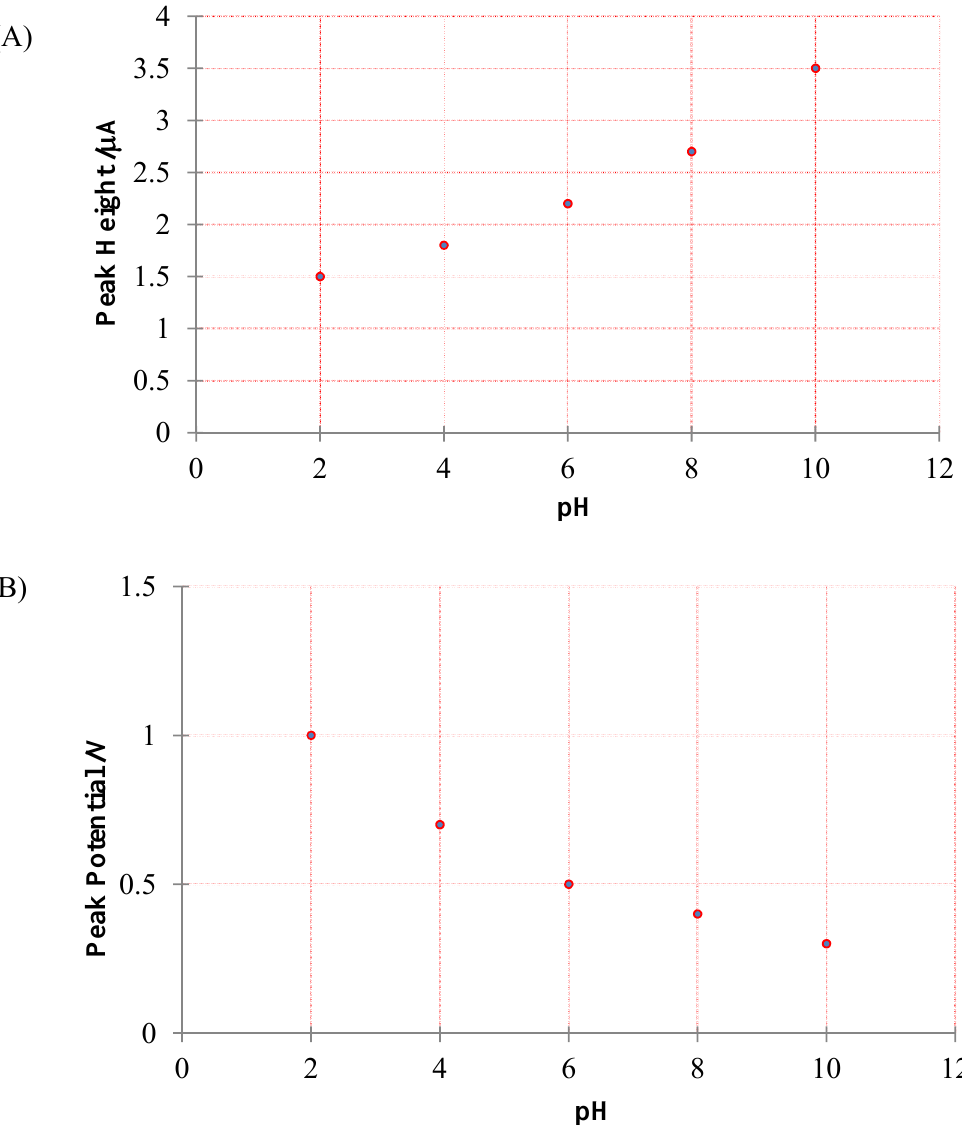
Figure 3. ( A ) A plot of peak potential, EP (A1), as a function of pH for the electrochemical oxidation of 1 µg/mL Rohypnol using SPEs. Scan rate: 100 mV − 1 . ( B ) A plot of peak height, IP (A1), as a function of pH for the electrochemical oxidation